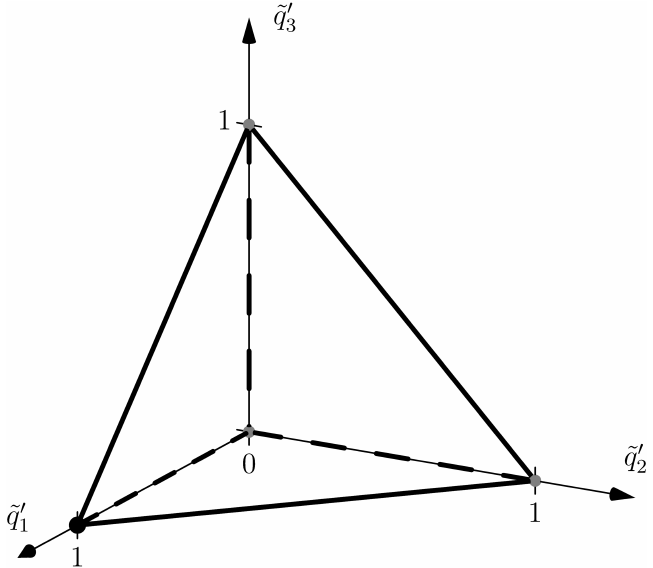
Figure 2. The polyhedron Γ ( f 1 ) of the first equation of the system (11). The boldface point corre- sponds to the first equation of the truncated system (13).